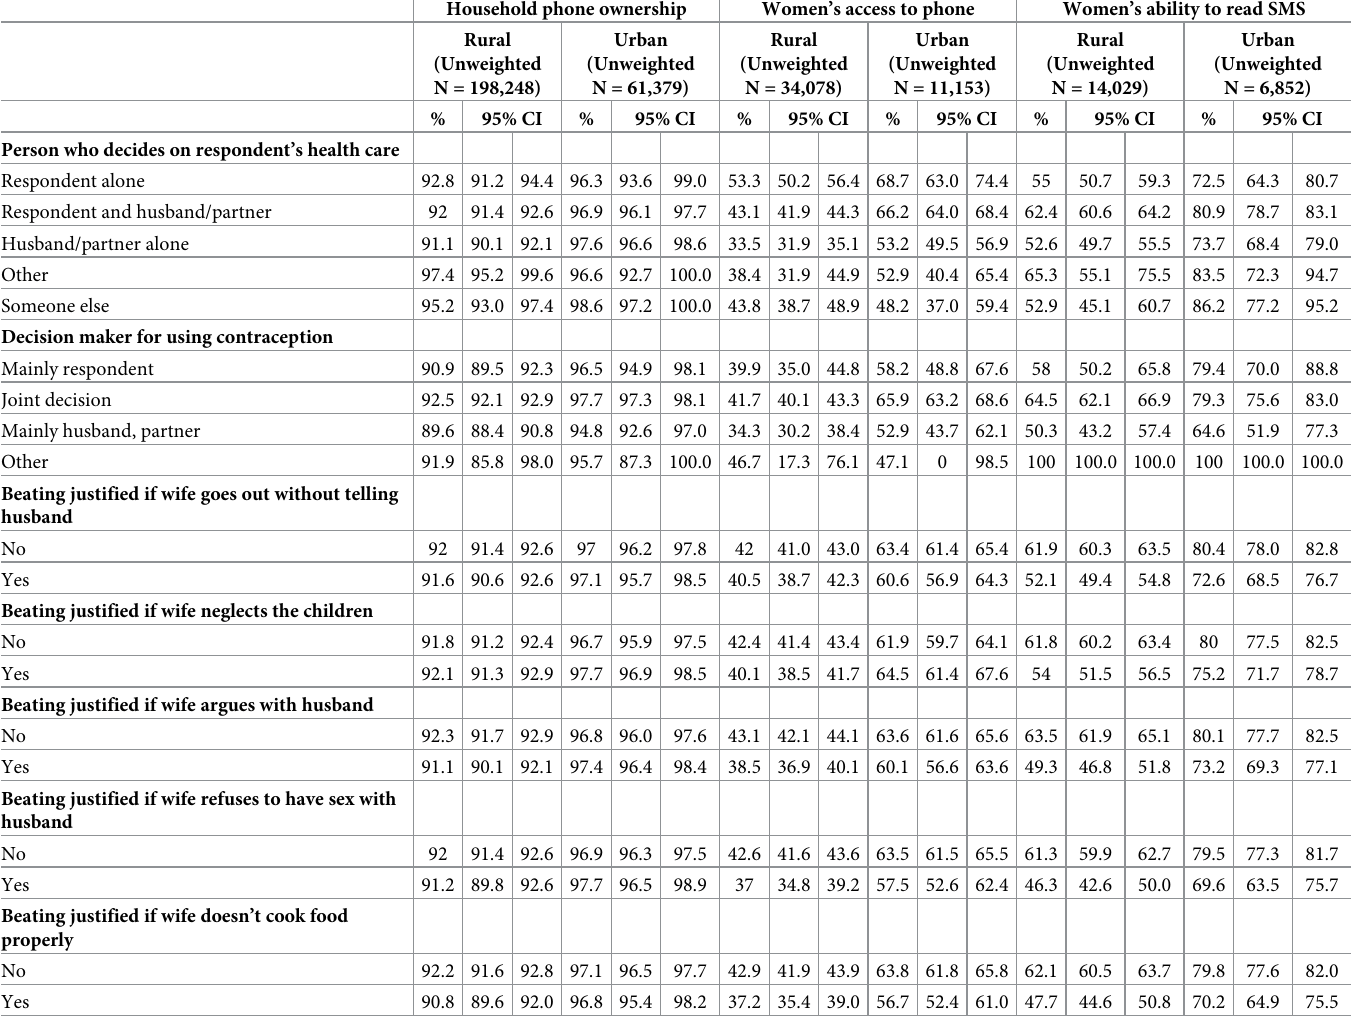
Table 2 explores the association between decision making and gender norms on phone access. Women who report they alone decide on their health care report higher phone access than those whose husband made the decision and those who made joint decisions across both rural (53.3% vs 33.5%) and urban (68.7% vs 53.2%) settings. For contraception, women report- ing joint decisions were more likely to report mobile phone access than those where the hus- band made the decisions. This held true in both rural (41.7% vs 34.3%) and urban (65.9% vs Table 2. Mobile phone ownership and use by variables for decision making and partner communication. Household phone ownership Women’s access to phone Women’s ability to read SMS Rural